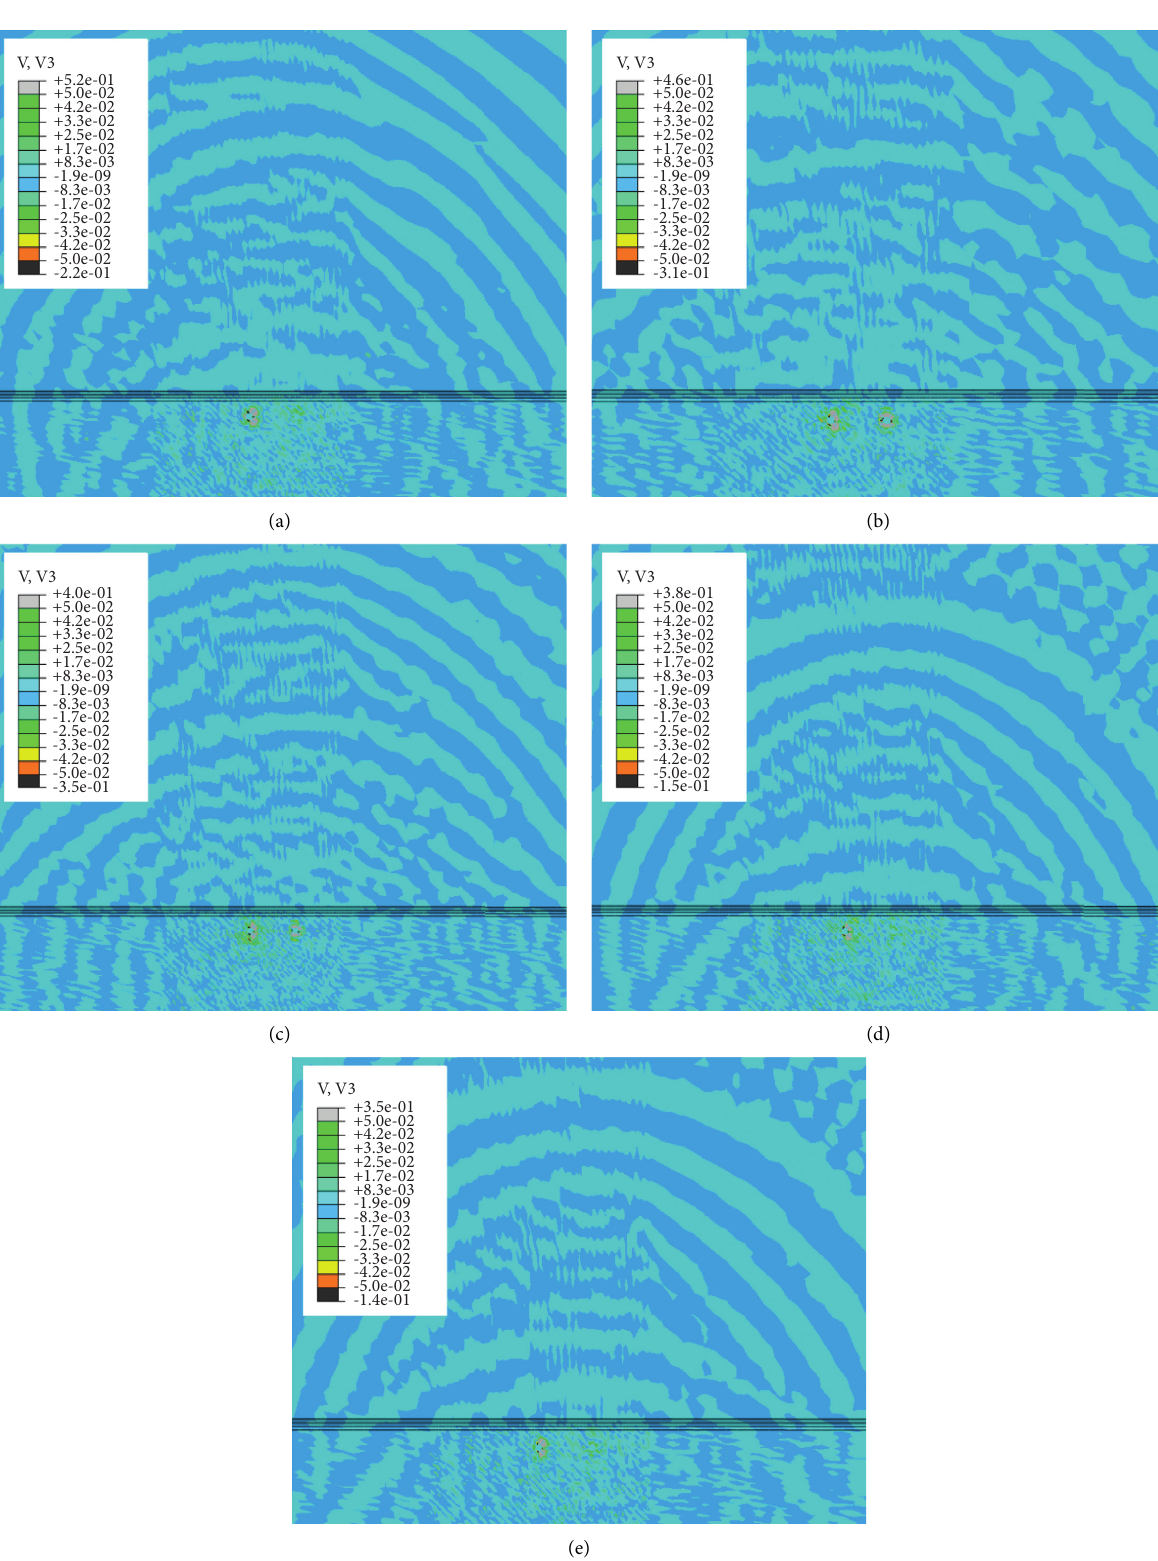
Figure 12: Comparison of the cloud plots of the peak vertical vibration velocities at different measuring points with different time intervals (m/s; for the horizontal arrangement): (a) 1 s, (b) 3s, (c) 5s, (d) 8s, and (e) 10